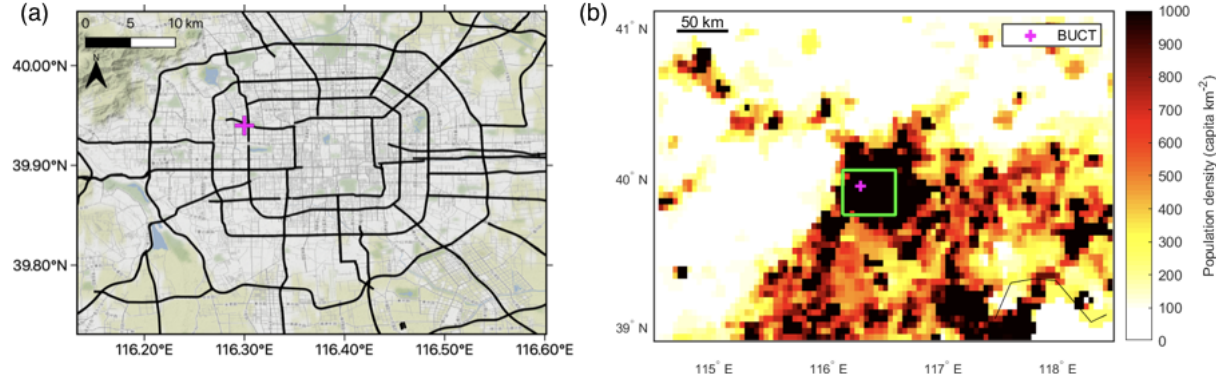
Figure 1. The maps of (a) urban Beijing and its main roads and (b) the region around Beijing with the population density (year 2015) shown as colors. The location of the measurement site of BUCT is shown with a magenta cross on both maps. The green rectangle in (b) corresponds to the region shown in (a) . In (a) the map data are obtained from Stamen Design (CC BY 3.0) and © OpenStreetMap contributors 2020, distributed under a Creative Commons BY-SA License (ODbL). In (b) the population density data are obtained from Gridded Population of the World (GPWv4.10; CC BY 4.0).